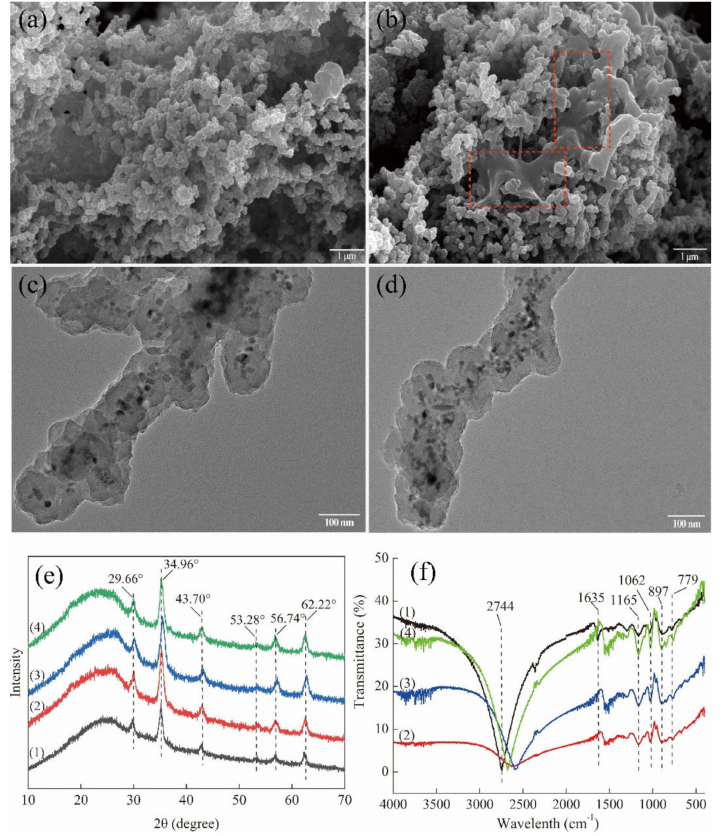
Figure 7. Characteristics of the Fe 3 O 4 @PPy composites after recycling once and twice. SEM images of Fe 3 O 4 @PPy composites reused ( a ) once and ( b ) twice. TEM images of Fe 3 O 4 @PPy composites reused ( c ) once and ( d ) twice. ( e ) XRD and ( f ) FTIR spectra of Fe 3 O 4 @PPy composites. The numbered spectra represent (1) Fe 3 O 4 @PPy, (2) Fe 3 O 4 @PPy after adsorption of VD 3 , (3) Fe 3 O 4 @PPy after